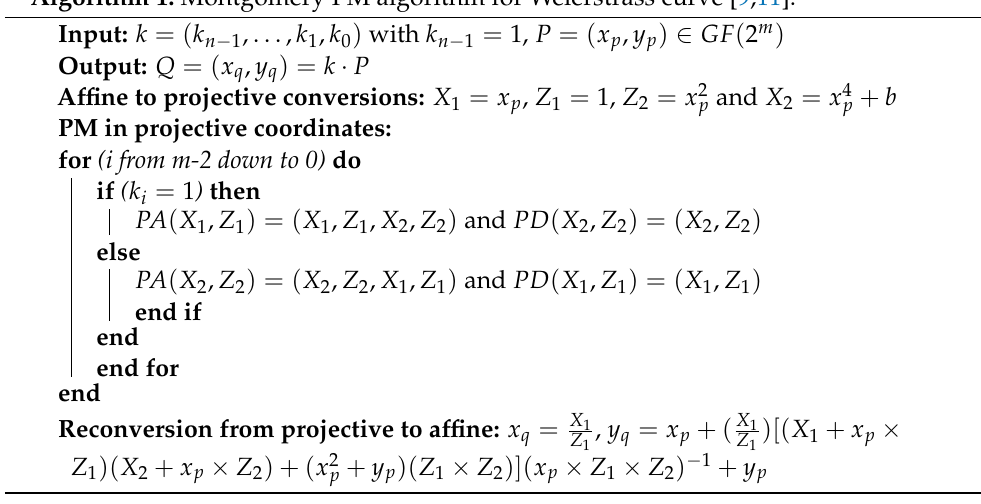
Algorithm 1: Montgomery PM algorithm for Weierstrass curve [9,11].